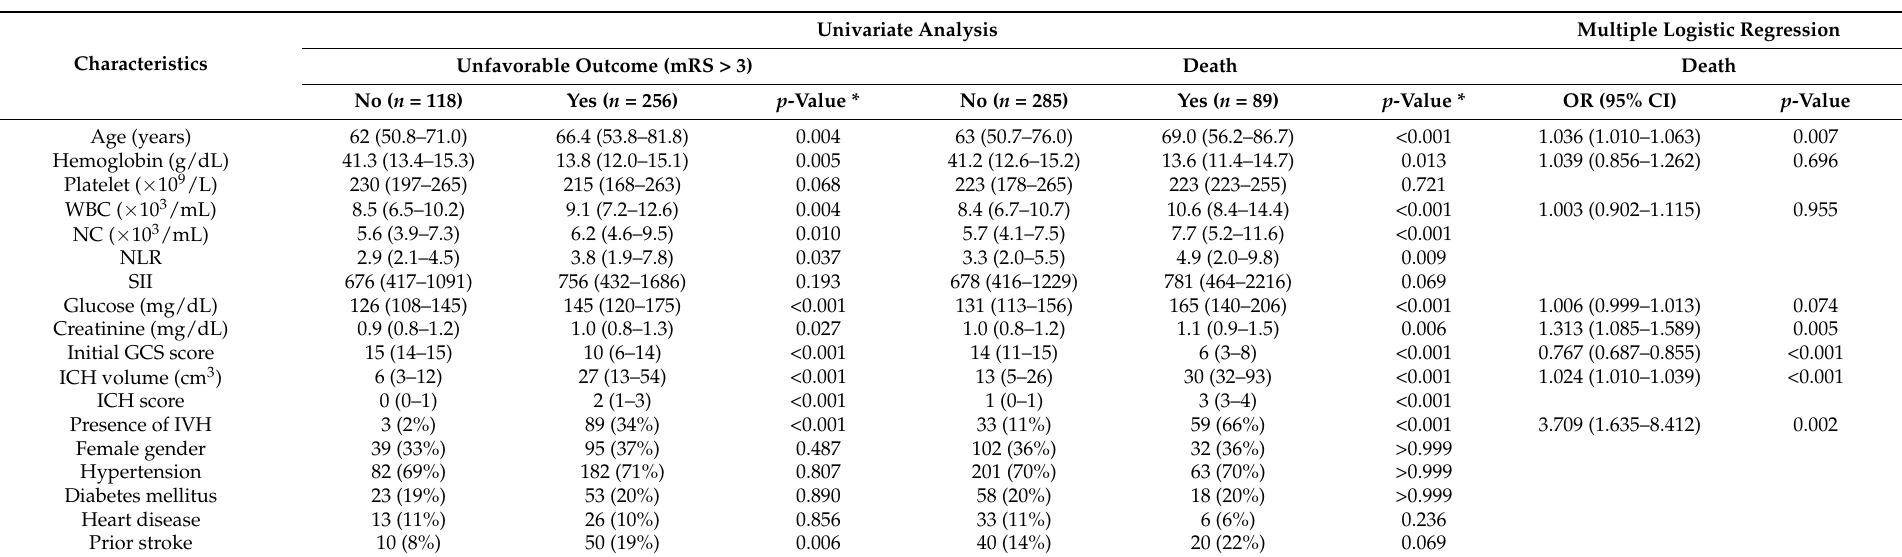
Table 4. Univariate and multivariable analyses of clinical features and outcomes in 374 patients with lobar and putaminal hemorrhage.